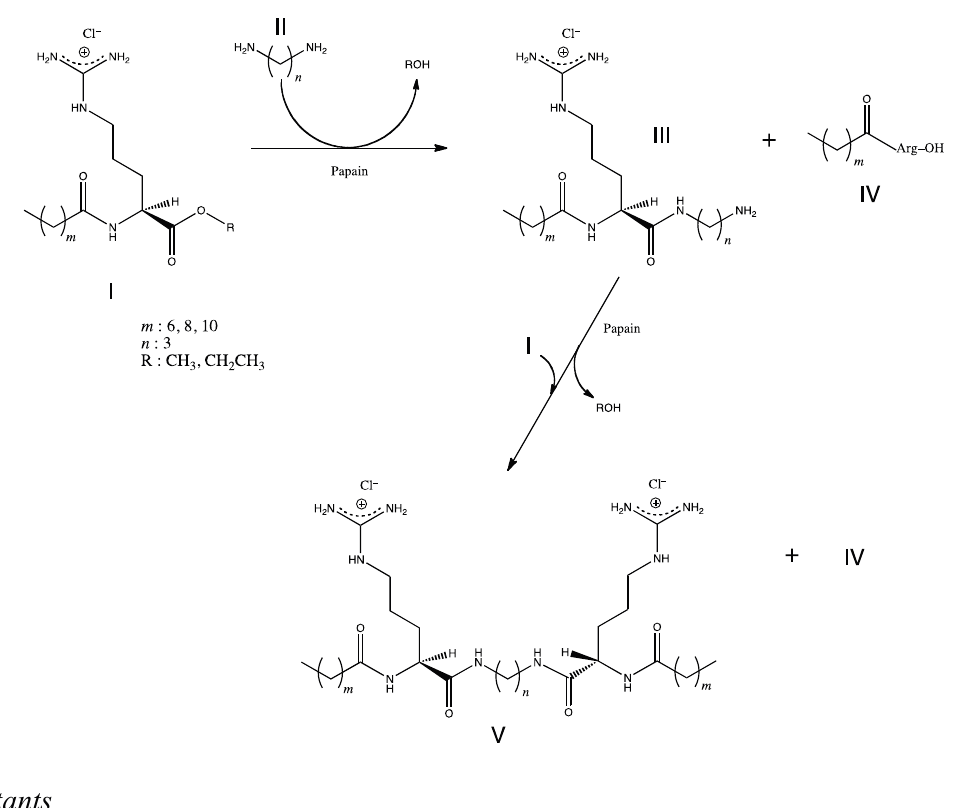
Figure 7. Scheme of the enzymatic synthesis of arginine-based gemini cationic surfactants: N α -acyl- L -Arginine alkyl ester monohydrochloride (acyl-donor) I , α , ω -diaminoalkane II , N α -acyl- L -arginine( ω